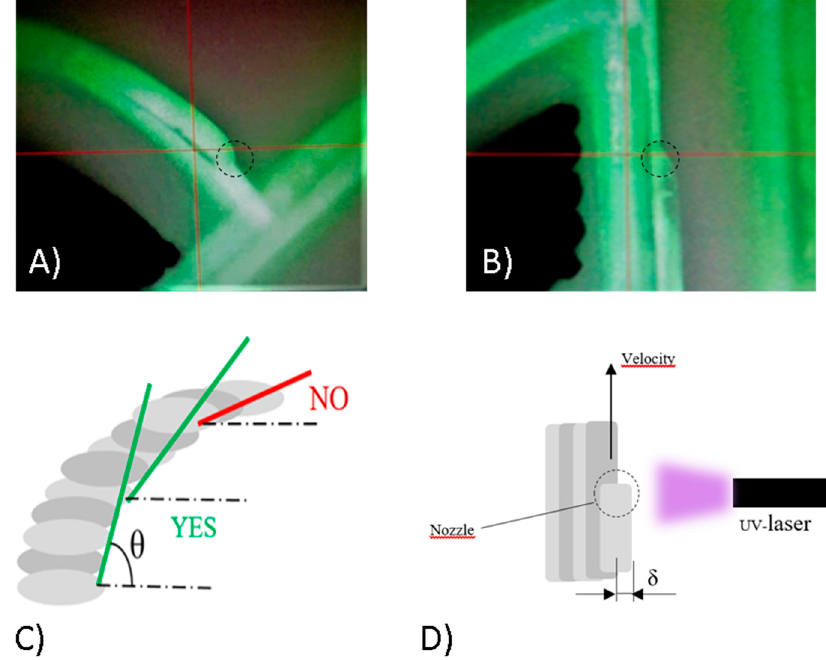
Figure 4. Process camera photo during printing of ( A ) a chamber wall and ( B ) a microchannel cantilevered line; representation of the critical angle ( C ); printing scheme and line offset δ ( D ).